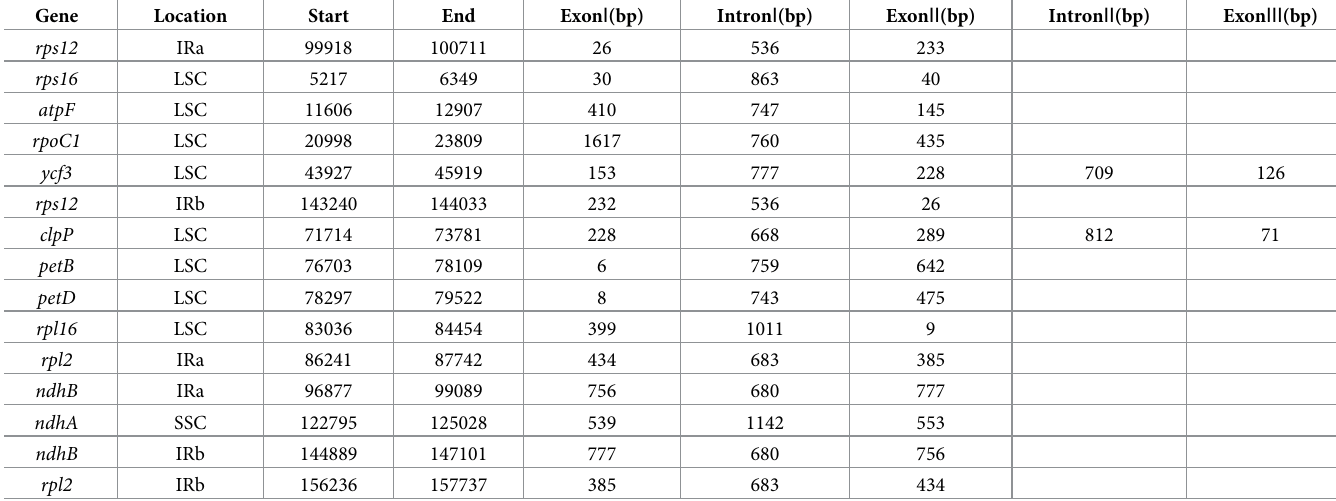
except for P . avium , showed the same fragment size of 279 bp in all species (Fig 2). The frag- ment size ranges from 175 to 239 bp in the IRb region while the tail section of the gene located in the LSC region ranged from 40 to 104 bp (Fig 2). The ycf1 gene is a critical gene that crossed the SSC/IRa border with 4,546–4,580 bp in the SSC regions and 1,041–1,069 bp in the IRa regions. The ndhF gene ranged from 2,237 to 2,285 bp and was located in the boundary of the IRb/SSC region in these tested species. However, the whole ndhF gene was situate in the SSC region in P . campanulata , P . conradinae , P . discoidea , P . emarginata , P . itosakura , P . jamasa-